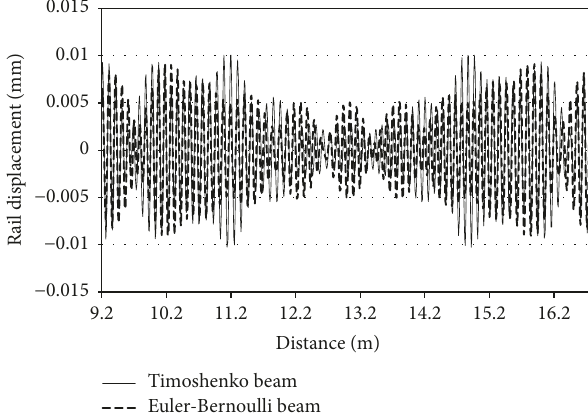
Figure 9: Steady-state response of rail modelled by Timoshenko and Euler-Bernoulli beams ( Δ𝑃 = 10 kN, 𝜔 = 5236 rad/s, V = 300